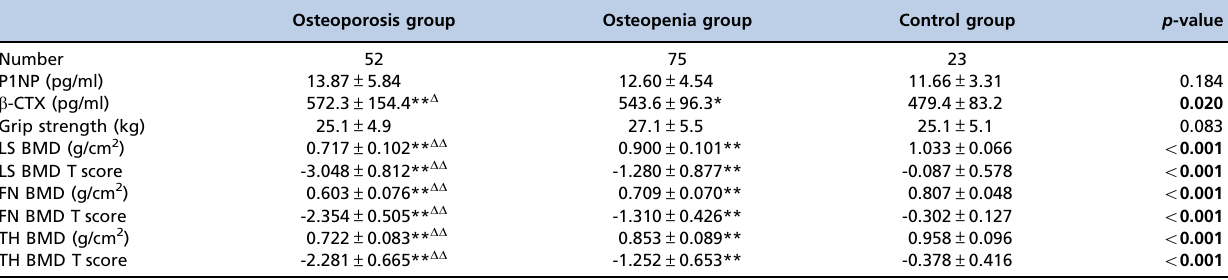
Table 2 - Comparison of bone turnover biomarker levels and BMD between the three